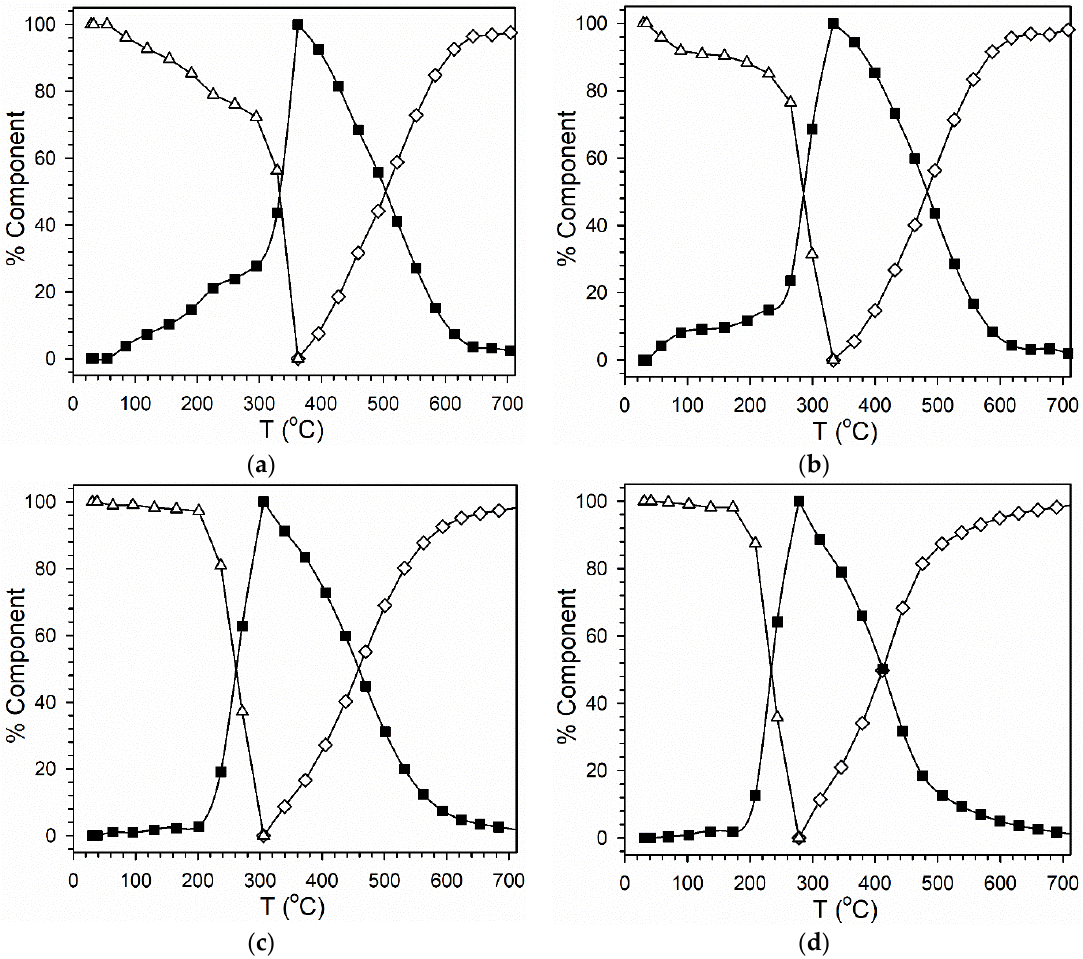
Figure 14. LC fittings of H 2 -TPR-XANES spectra at the Ni K-edge of ( a ) 25%M (M = 5%Ni- Figure14. LCfittingsofH 2 -TPR-XANESspectraattheNiK-edgeof( a )25%M(M = 5%Ni-95%Co) / Al 2 O 3 , 95%Co)/Al 2 O 3 , ( b ) 25%M (M = 10%Ni-90%Co)/Al 2 O 3 , ( c ) 25%M (M = 25%Ni-75%Co)/Al 2 O 3 , and ( d ) ( b ) 25%M (M = 10%Ni-90%Co) / Al 2 O 3 , ( c ) 25%M (M = 25%Ni-75%Co) / Al 2 O 3 , and ( d ) 25%M 25%M (M = 50%Ni-50%Co)/Al 2 O 3 . Legend:  Ni 2+ associated with Co 3 O 4 ,  Ni 2+ associated with CoO, (M = 50%Ni-50%Co) / Al 2 O 3 . Legend: (cid:52) Ni 2 + associated with Co 3 O 4 , (cid:4) Ni 2 + associated with CoO, and and  Ni 0 associated with Co 0 . Ni 0 associated with Co 0 (cid:51)